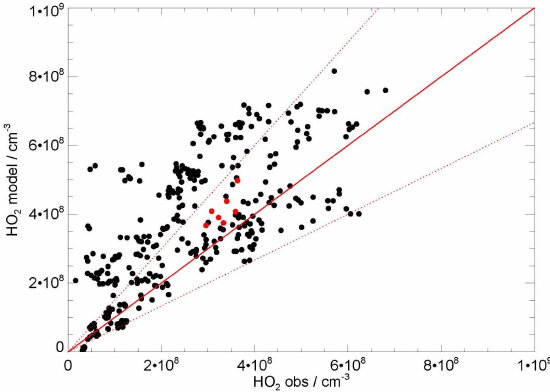
Fig. 14. Comparison between HO 2 modeled and observed concentrations using measurements made on board the BAe-146. In red are the data corresponding with the intercomparison period.